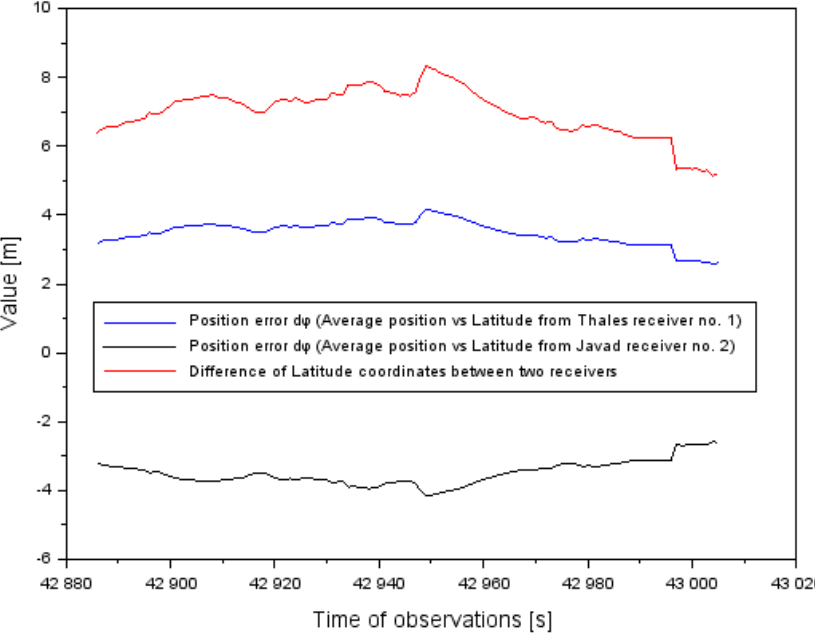
Figure 12. The position error of aircraft coordinates ϕ in the air test in Chełm.